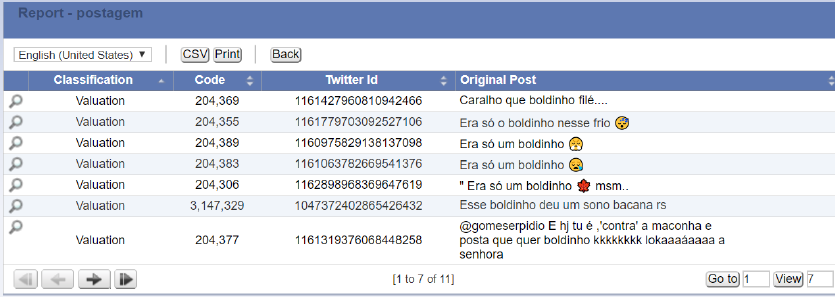
Figure 7. Search interface of the SocCrime Prototype.